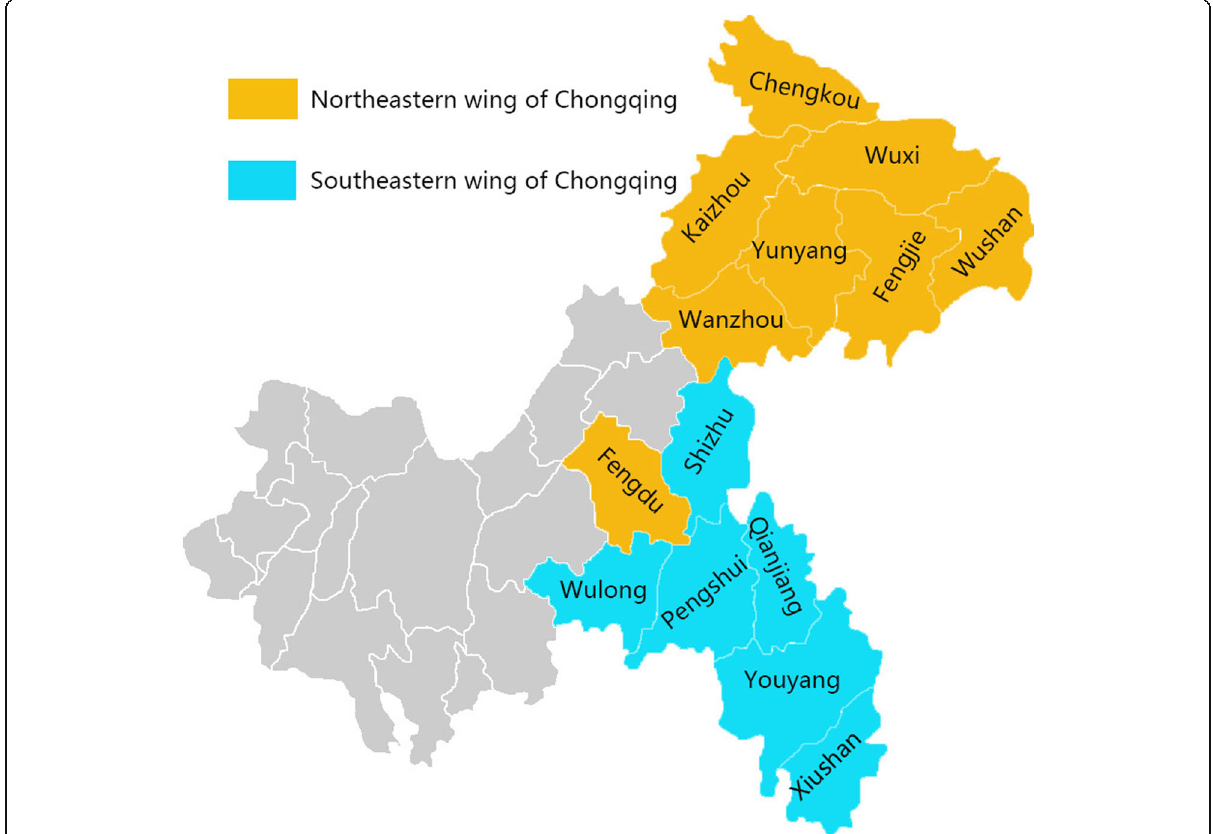
Fig. 2 Location distribution of 14 poverty state counties in